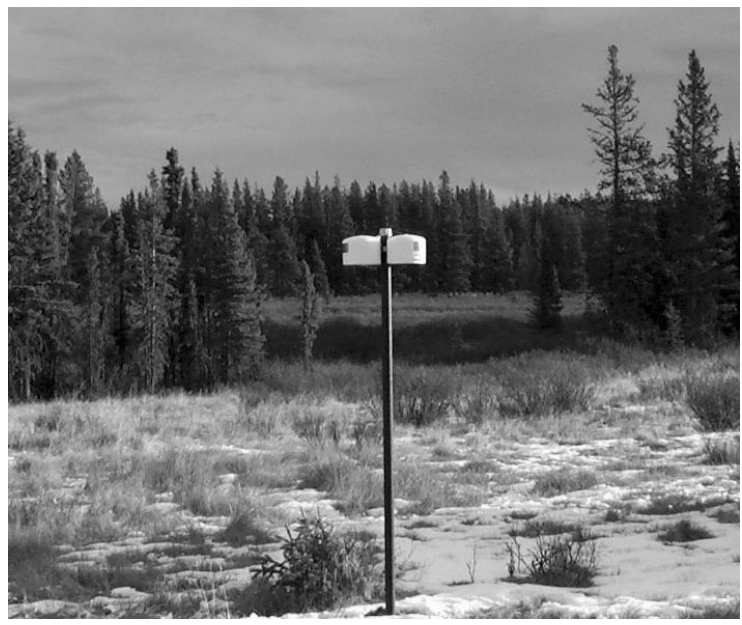
FIGURE 9. PASS multi-rain shelter installation (courtesy from PAMZ).